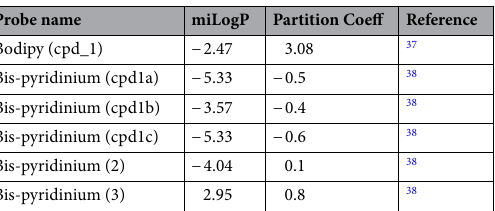
Table 1. Comparison of miLogP and experimental partition coefficient values. Partition Coeff. = Experimental Partition